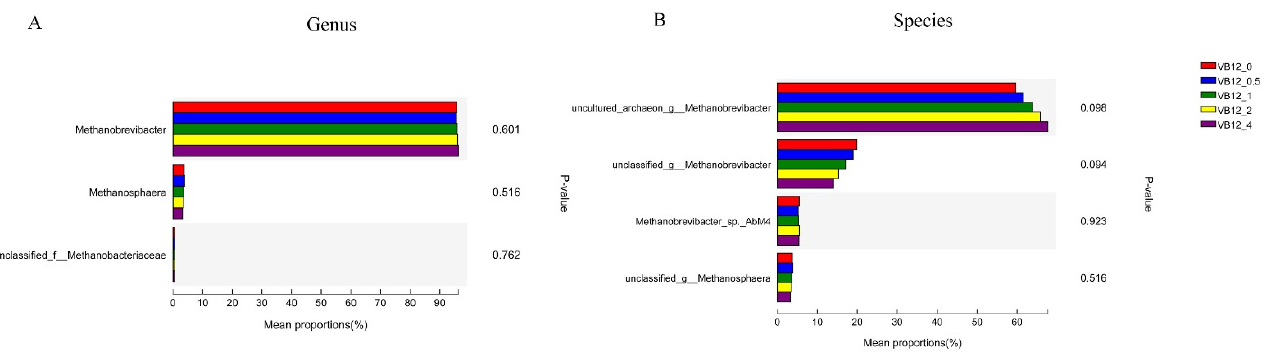
Figure 5. Changes in the archaeal genus ( A ) and species ( B ) level in the rumen fermentation system with increasing vitamin B 12 supplementation.